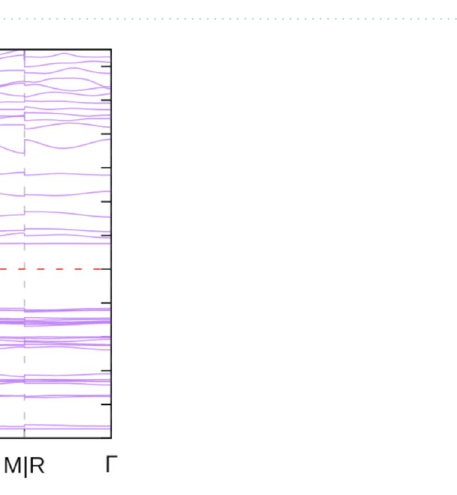
Figure 3. Crystal structure of the N 5 AsF 6 at 0 K and 0 Gpa projected along [010] direction. The first (left) and second (right) accoustic phonon branches causing instability are librational and are depicted by forces on each atom. All forces are pointing in the same parallel thus perturbing the whole crystal in the same direction.